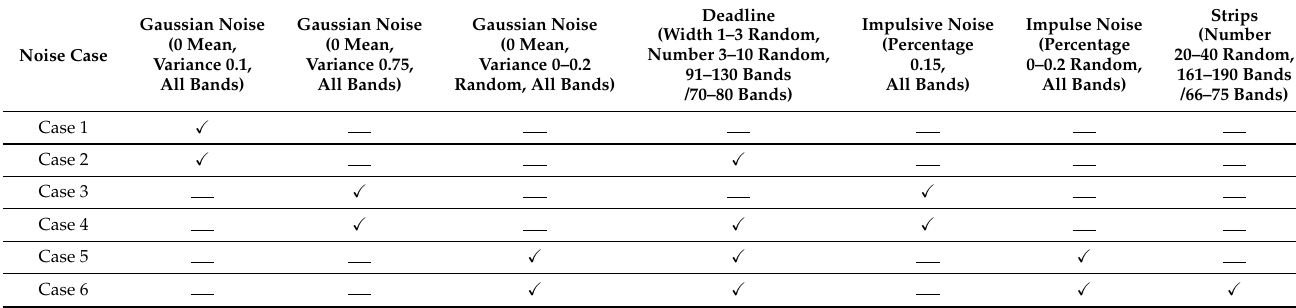
Table 2. Different noise scenarios for synthetic HSI